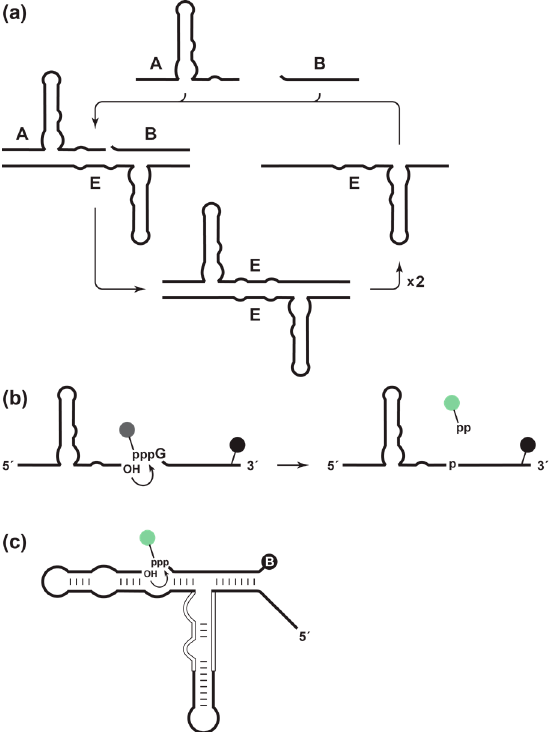
Figure 1. Amplification and detection of a self-replicating RNA enzyme. ( a ) The enzyme (E) catalyzes ligation of substrates A and B to form a new copy of E. The E•E complex then dissociates to begin the next replication cycle; ( b ) For real-time fluorescence detection, substrate B contains both a fluorophore linked to the 5 ′ - γ -phosphate and a quencher at the 3 ′ -end (shaded circles). Upon ligation, the fluorophore is released and no longer quenched; ( c ) The enzyme was evolved to accept 5 ′ -fluorophore-labeled substrate B by introducing random mutations throughout its catalytic center (open lines), joining the 5 ′ -end of substrate A to the 3 ′ -end of E, and selecting molecules that catalyze ligation of 3 ′ -biotinylated substrate B through their capture on streptavidin.